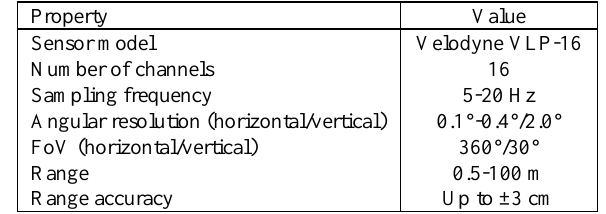
Table 2 . Specifications of the LiDAR sensor used in evaluating the generated point clouds.